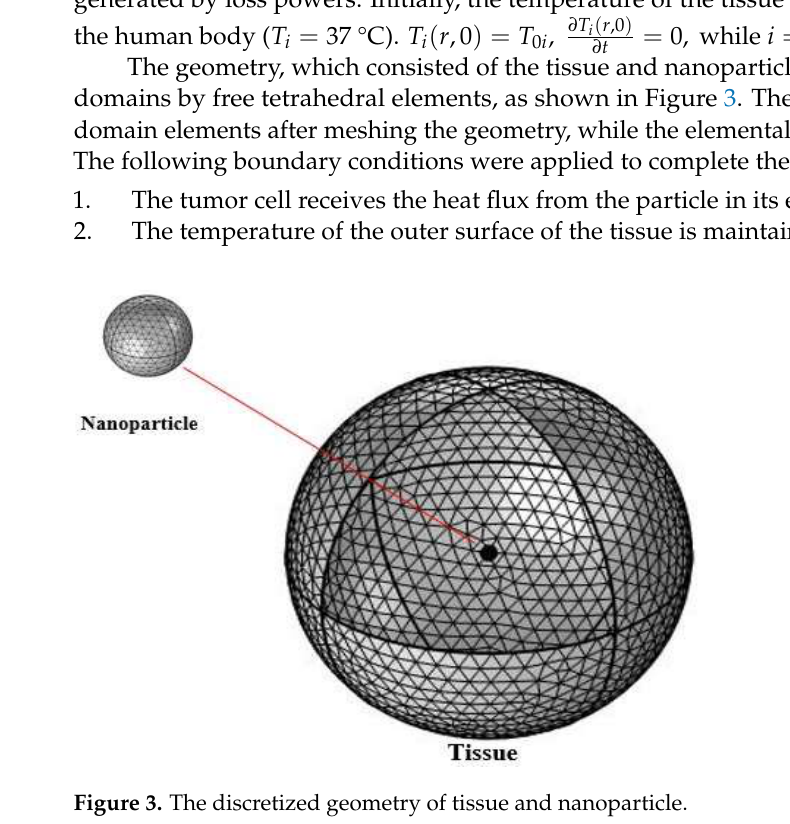
Figure 5. The core–shell structure simulated in COMSOL Multiphysics: ( a ) naked core with radius of 20 nm, with AgNPs with 4 nm radius attached to the core surface, ( b ) core (0 NP) and ( c – e ) 10, 40 and 70 nanoparticles attached to core, ( f ) complete shell (100 NPs) . Table 2. Thermal response of source materials used in this work. Thermal Conductivity [W/m*k]